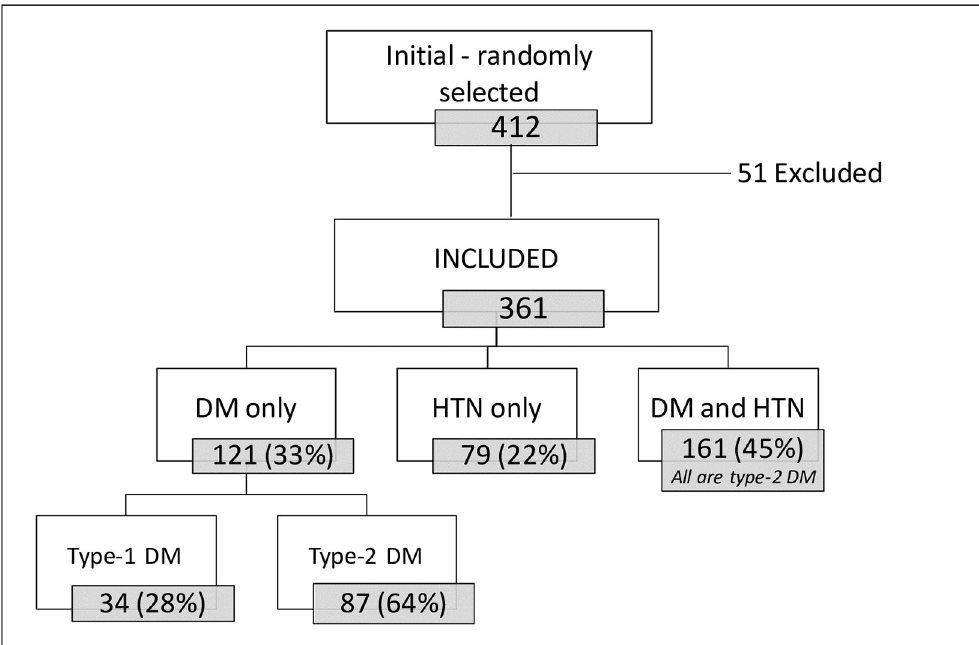
Fig 1. Flowchart of study participants among patients with diabetes and/or hypertension, Me´decins Sans Fronti è res Shatila refugee camp, Beirut, Lebanon, October 2018.